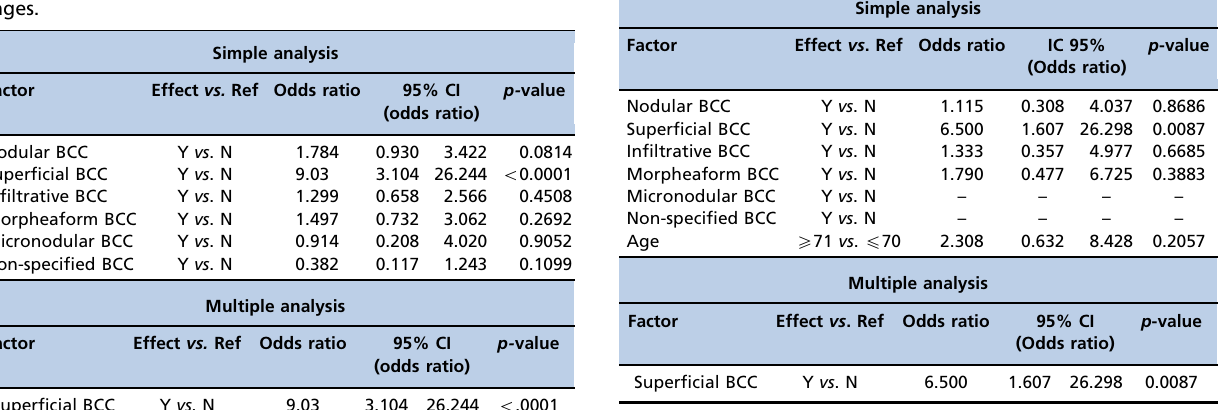
Table 5 - The results of the binary logistic regression used to evaluate factors associated with complications. Simple analysis